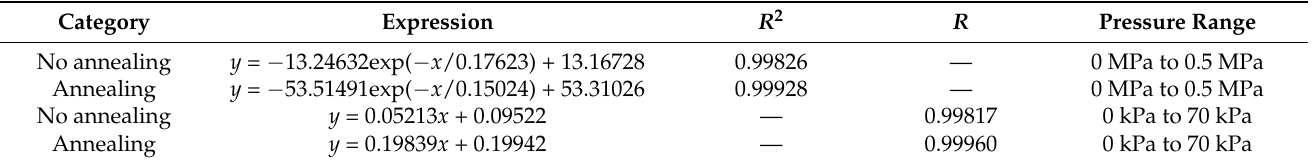
Figure 6. Voltage output as a function of the differential pressure: ( a ) optical image of the proposed sensor; ( b ) in the range of 0 MPa to 0.5 MPa; ( c ) in the range of 0 kPa to 70 kPa. Table 2. Relevant data of the fitting curves in Figure Table 1. Performance comparison among the MEMS pressure sensors.